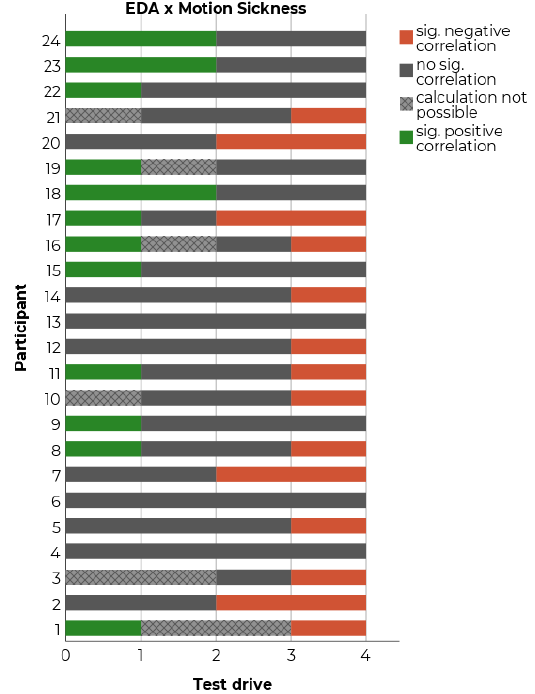
Figure 7. Count of significant Spearman correlations between EDA and motion sickness for each test drive and each participant.